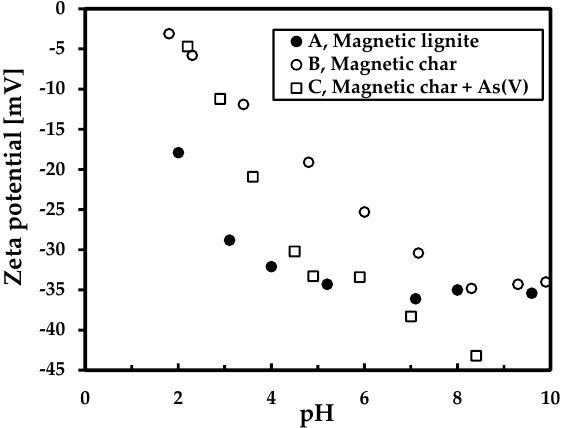
Figure 3. Zeta potential of the sorbents at various pHs in 0.1 M NaNO 3 (sample C: c (AsV) = 100 ppm).